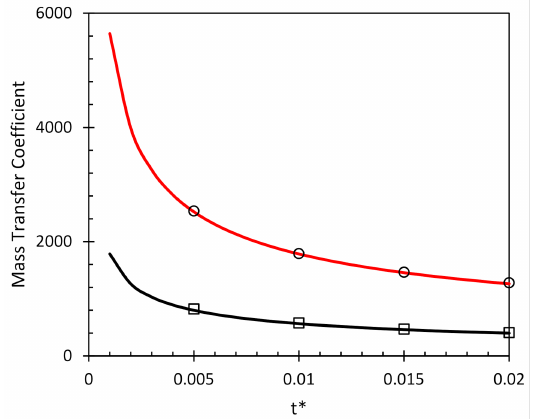
Figure A5. Mass transfer coefficient as a function of time. Black and red lines are liquid and gas mass transfer, respectively, and dots are numerical results.